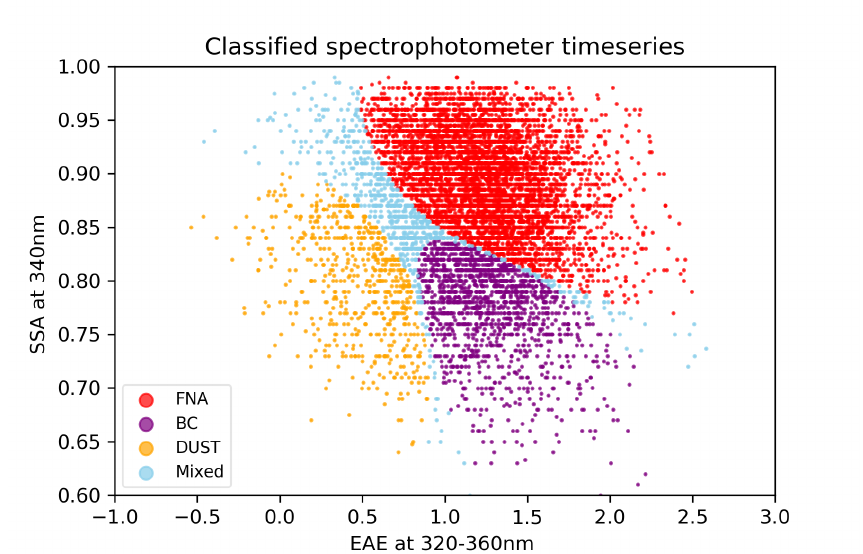
Figure 5. The full Brewer timeseries is presented here, automatically classified in the three predominant clusters and the mixed cluster.